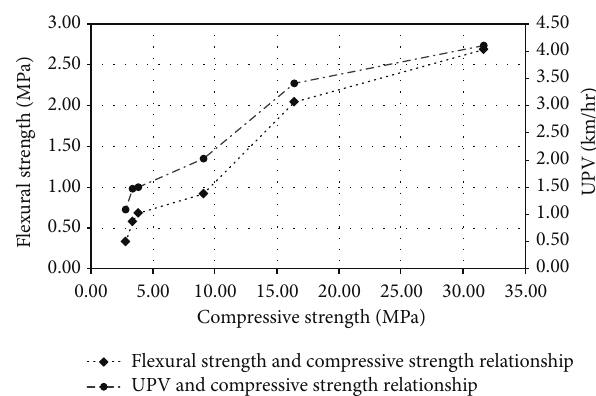
Figure 5: Comparative relationships of compressive strength, UPV values, and flexural